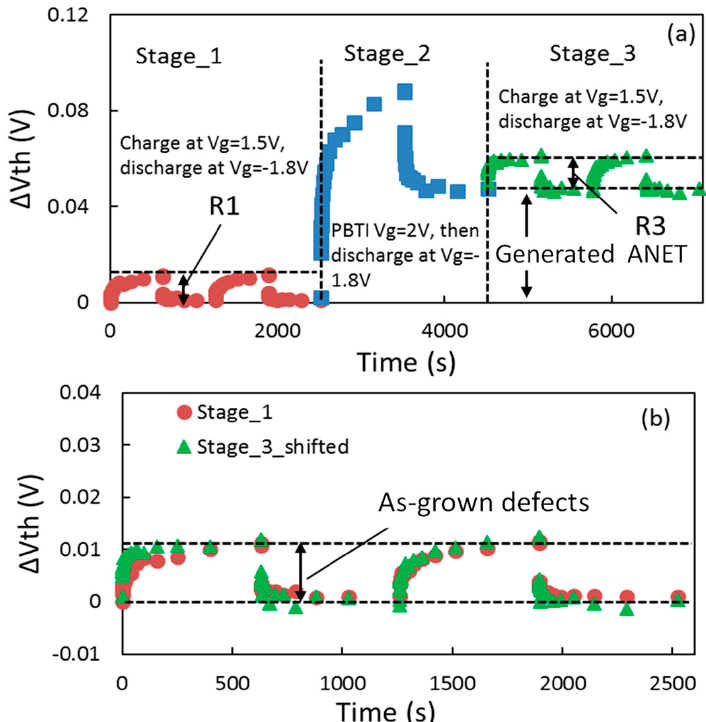
Figure 43. ( a ) Test sequence for confirming the presence of as-grown defects and the generated Anti-neutralization electron traps (ANETs) by PBTI; ( b ) a comparison of the as-grown defects pre- and post-heavy PBTI stress [55].